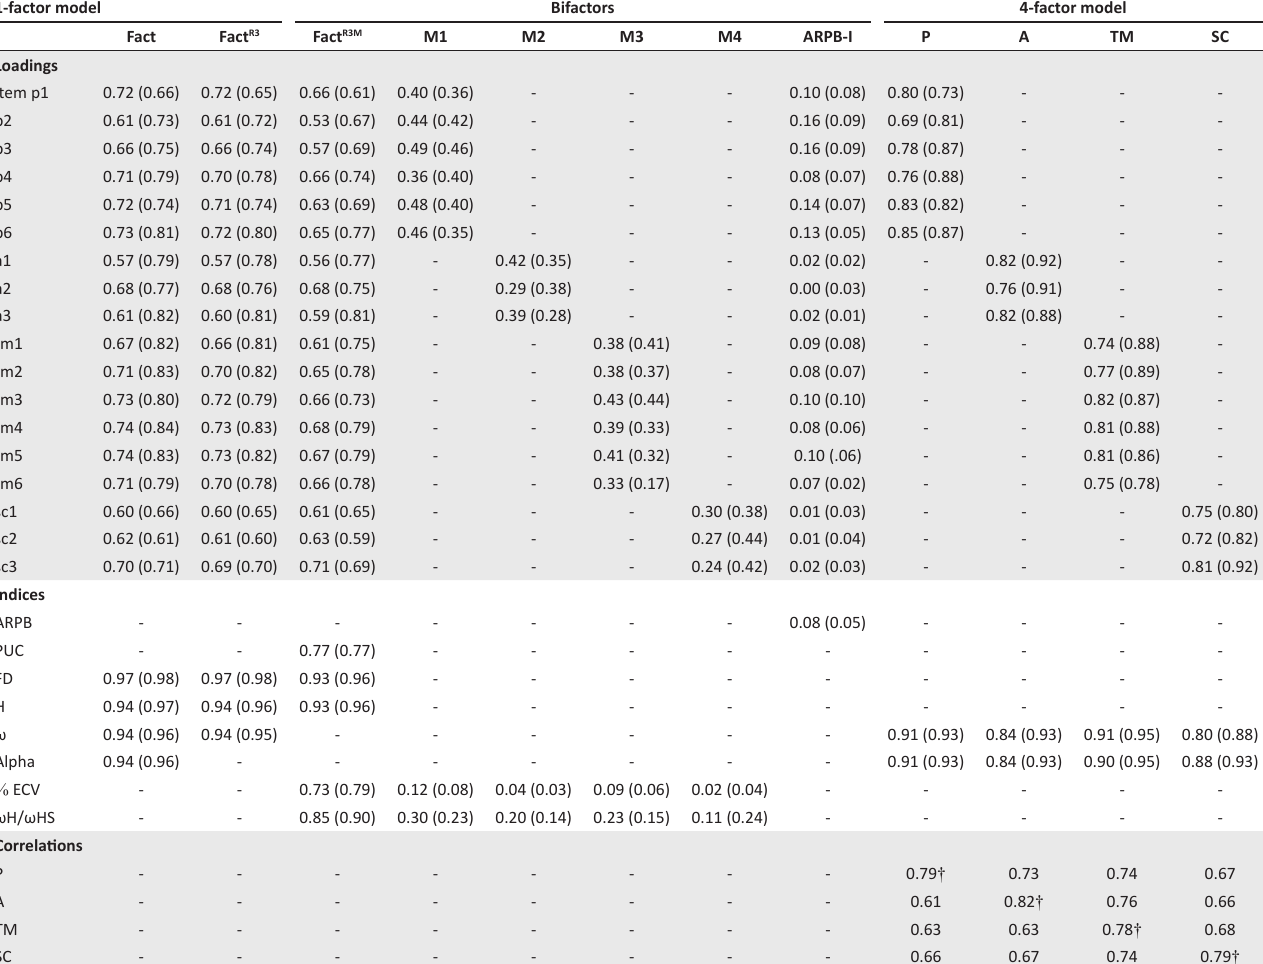
TABLE 2: The factor structure of the Bayesian structural equation modeling analyses. 1-factor